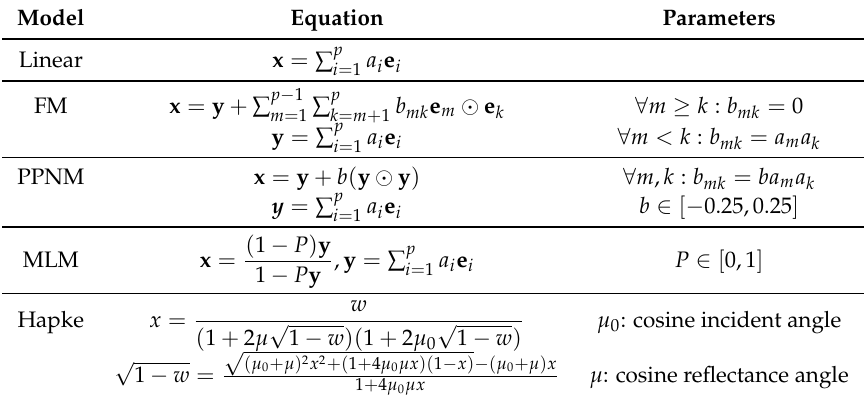
Table 1. Linear and nonlinear mixing models and their parameters. The assumptions for all models: ∀ m : a m ≥ 0, ∑ = m a m